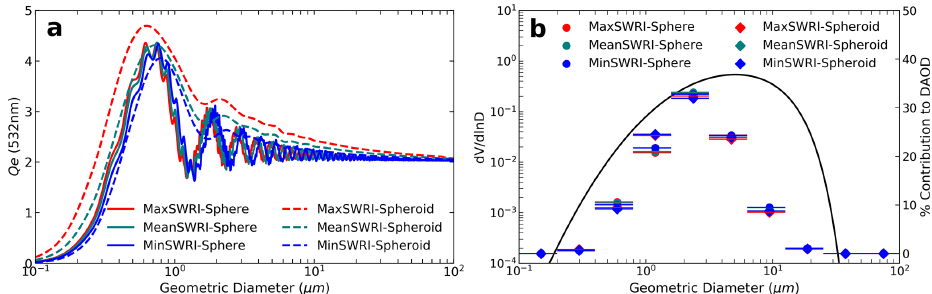
Figure 6. (a) Dust extinction efficiency ( Q e ) at 532nm for 6 dust models. (b) The colored bars represent f k calculated for six dust models based on a specific dust PSD (d V/ dln D ) indicated by the black curve. Note, f k is not sensitive to different dust models such as dust RI and dust shape.